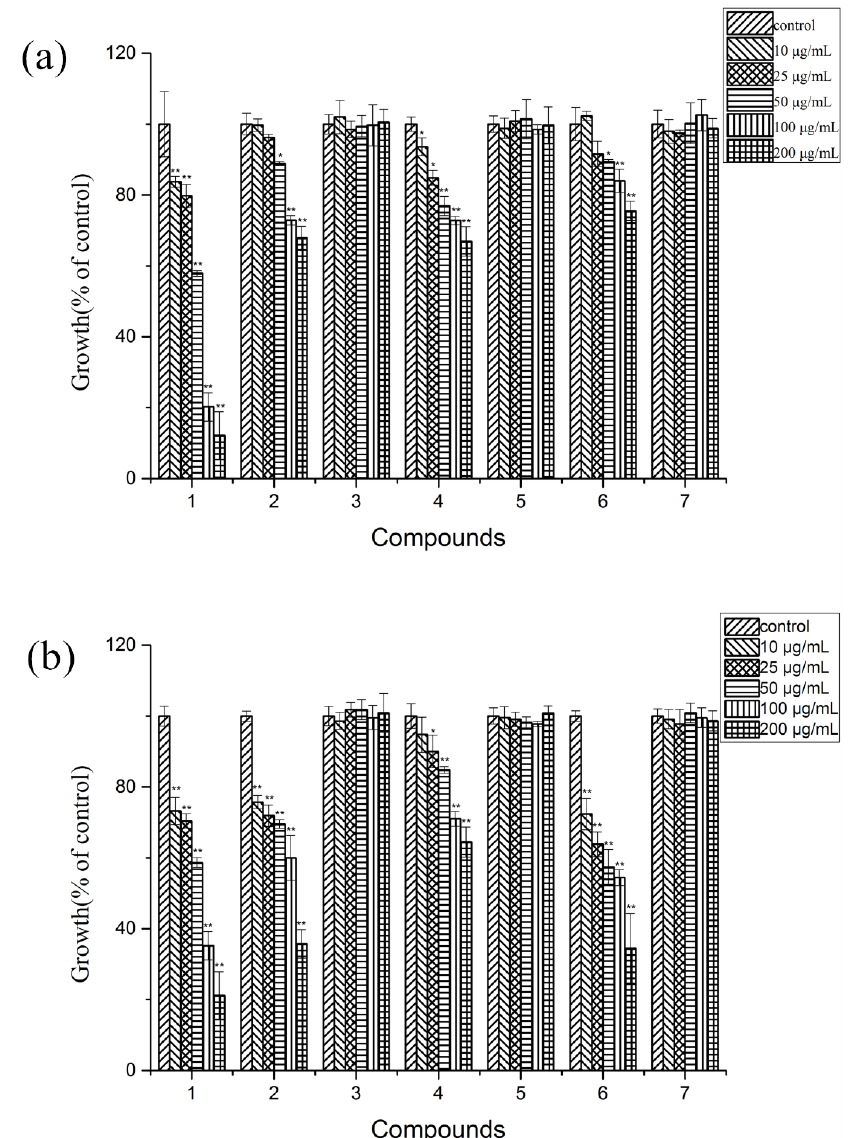
Figure 3. Phytotoxic effects of compounds 1 – 7 on root ( a ) and stems ( b ) lengths of L. sativa seedlings at concentrations of 10, 25, 50, 100, and 200 µ g/mL, respectively. Values are presented as a percentage of the mean compared to the control. Means significantly lower than the DMSO controls are indicated by * (one way ANOVA; p < 0.05) or ** ( p < 0.01). Error bars are one standard error of the mean. n = 3.